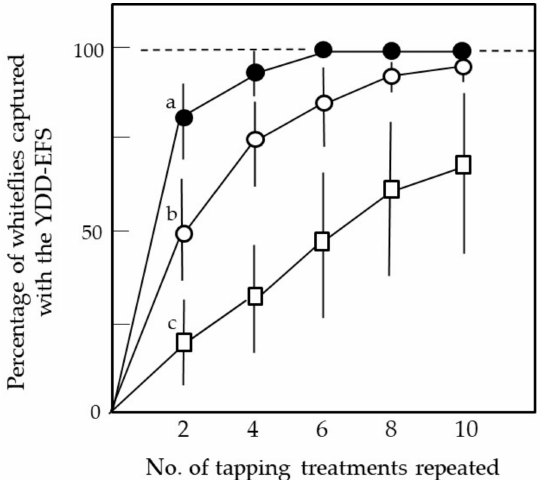
Figure 6. The numbers of whiteflies captured by the yellow-colored double-charged dipolar electric field screen (YDD-EFS) placed at different distances (30 (closed circle), 90 (open circle), and 150 (open square) cm) from a potted tomato plant. Adult whiteflies settled on the leaves and the plant was repeatedly tapped by the arms of the dolly (D-S 0 A 2 ) via reciprocating movements. The whiteflies that flew up were attracted to the YDD-EFS on the second dolly (D-S 1 A 0 ) placed on the opposite side of the plant. The whiteflies captured by the YDD-EFS were counted. Twenty whiteflies were used to test each distance, and the means and standard deviations were calculated from five experimental replicates. Letters (a–c) in each vertical column indicate significant differences ( p < 0.05) as revealed by a Tukey’s